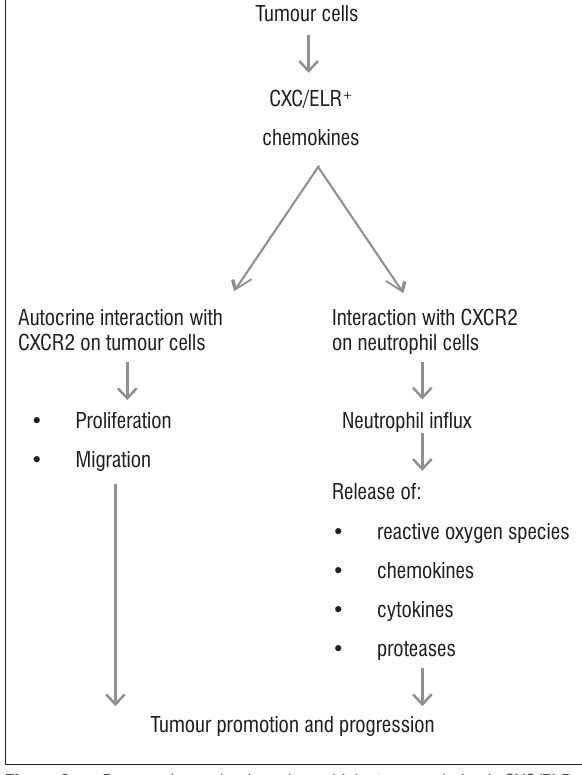
Figure 2: Proposed mechanism by which tumour-derived CXC/ELR + chemokines exacerbate promotion and progression via the au- tocrine induction of proliferation and metastasis, as well as by recruitment of pro-tumourigenic